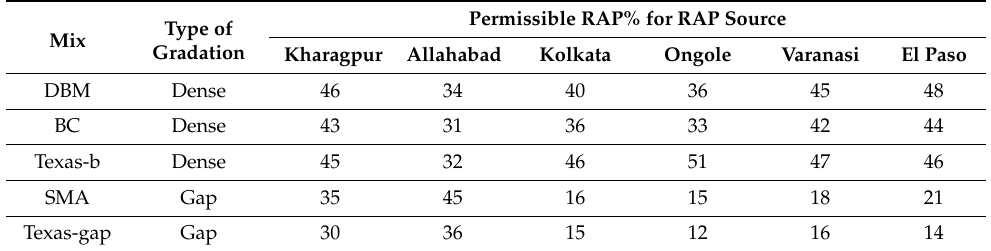
Table 12. Maximum Permissible RAP % Based on Target Aggregate